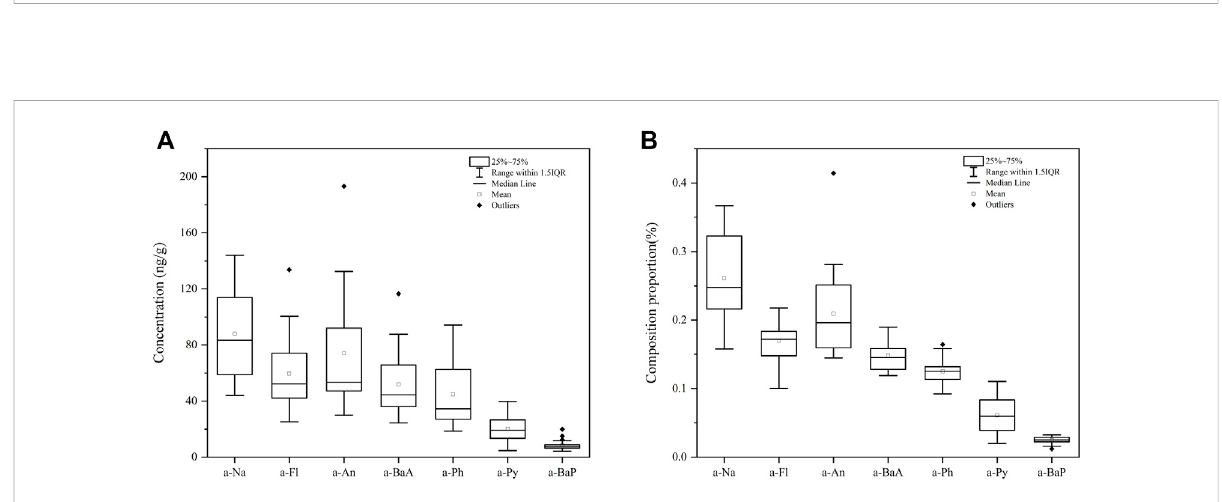
FIGURE 4 Box plot of a-PAHs homolog [concentration (A) ; proportion (B)